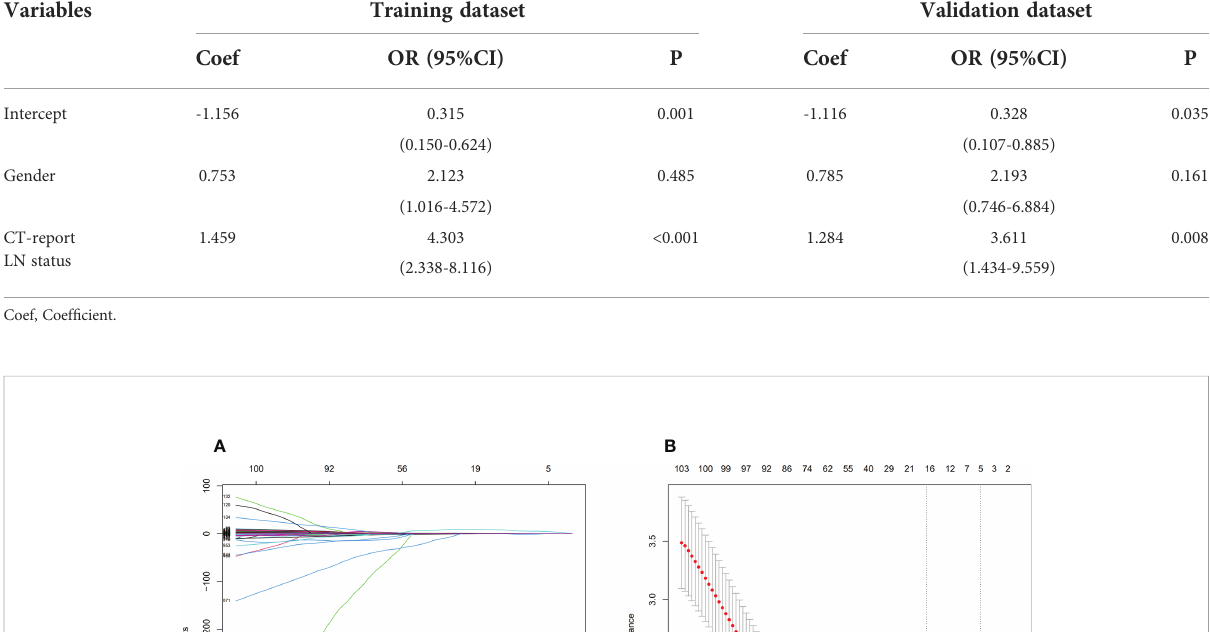
TABLE 2 Multivariate analysis in training and validation dataset.